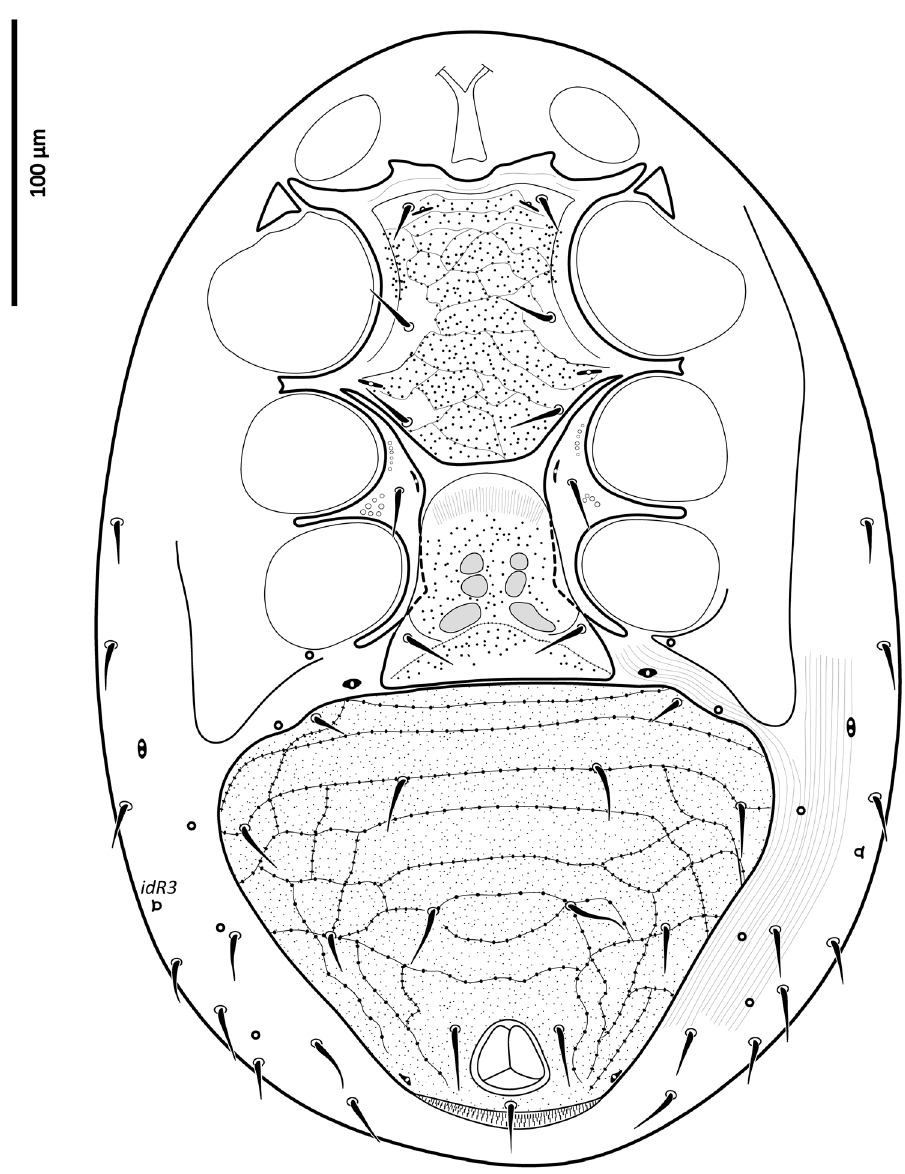
Figure 16. Zygoseius lindquisti sp. n., female, ventral idiosoma.